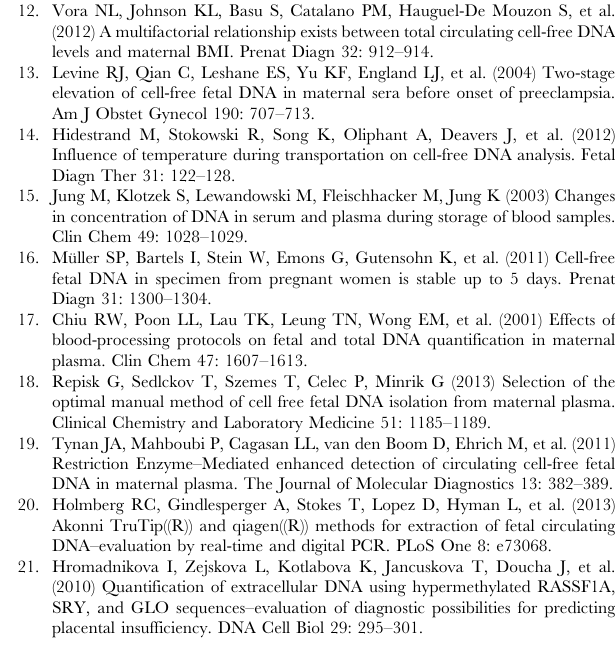
Table S2 qPCR evaluation of 8 samples purified with both DNeasy Blood&Tissue Kit and QIAamp Circulating Nucleic Acid Kit. Table S3 Paired sample t -test for qPCR RPP30 and RASSF1 measurements for two DNA extraction ap- proaches. Table S4 Primers and probes used in the study. Table S5 Normality test (Shapiro-Wilk). Table S6 Number of wells revealing specific amplifica- tion in qPCR assay in the samples negative for placental DNA according to ddPCR data. Table S7 Correlation of cfDNA levels with the gesta- tional age at blood draw